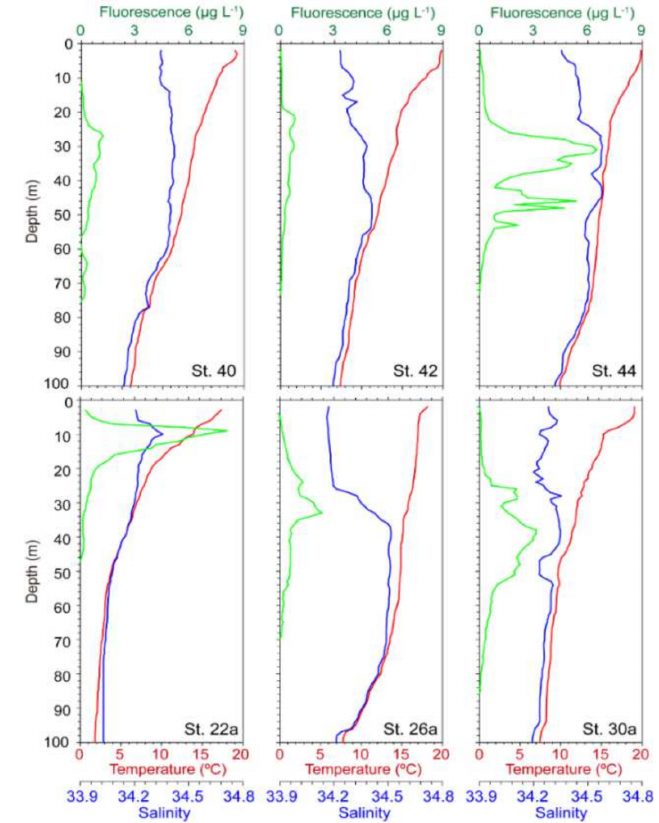
Figure 6. Vertical profiles of water temperature, salinity, and fluorescence during late spring at stations three stations on 3 June (Stns. 40, 42, and 44) and 7 June (Stns. 22a, 26a, St.